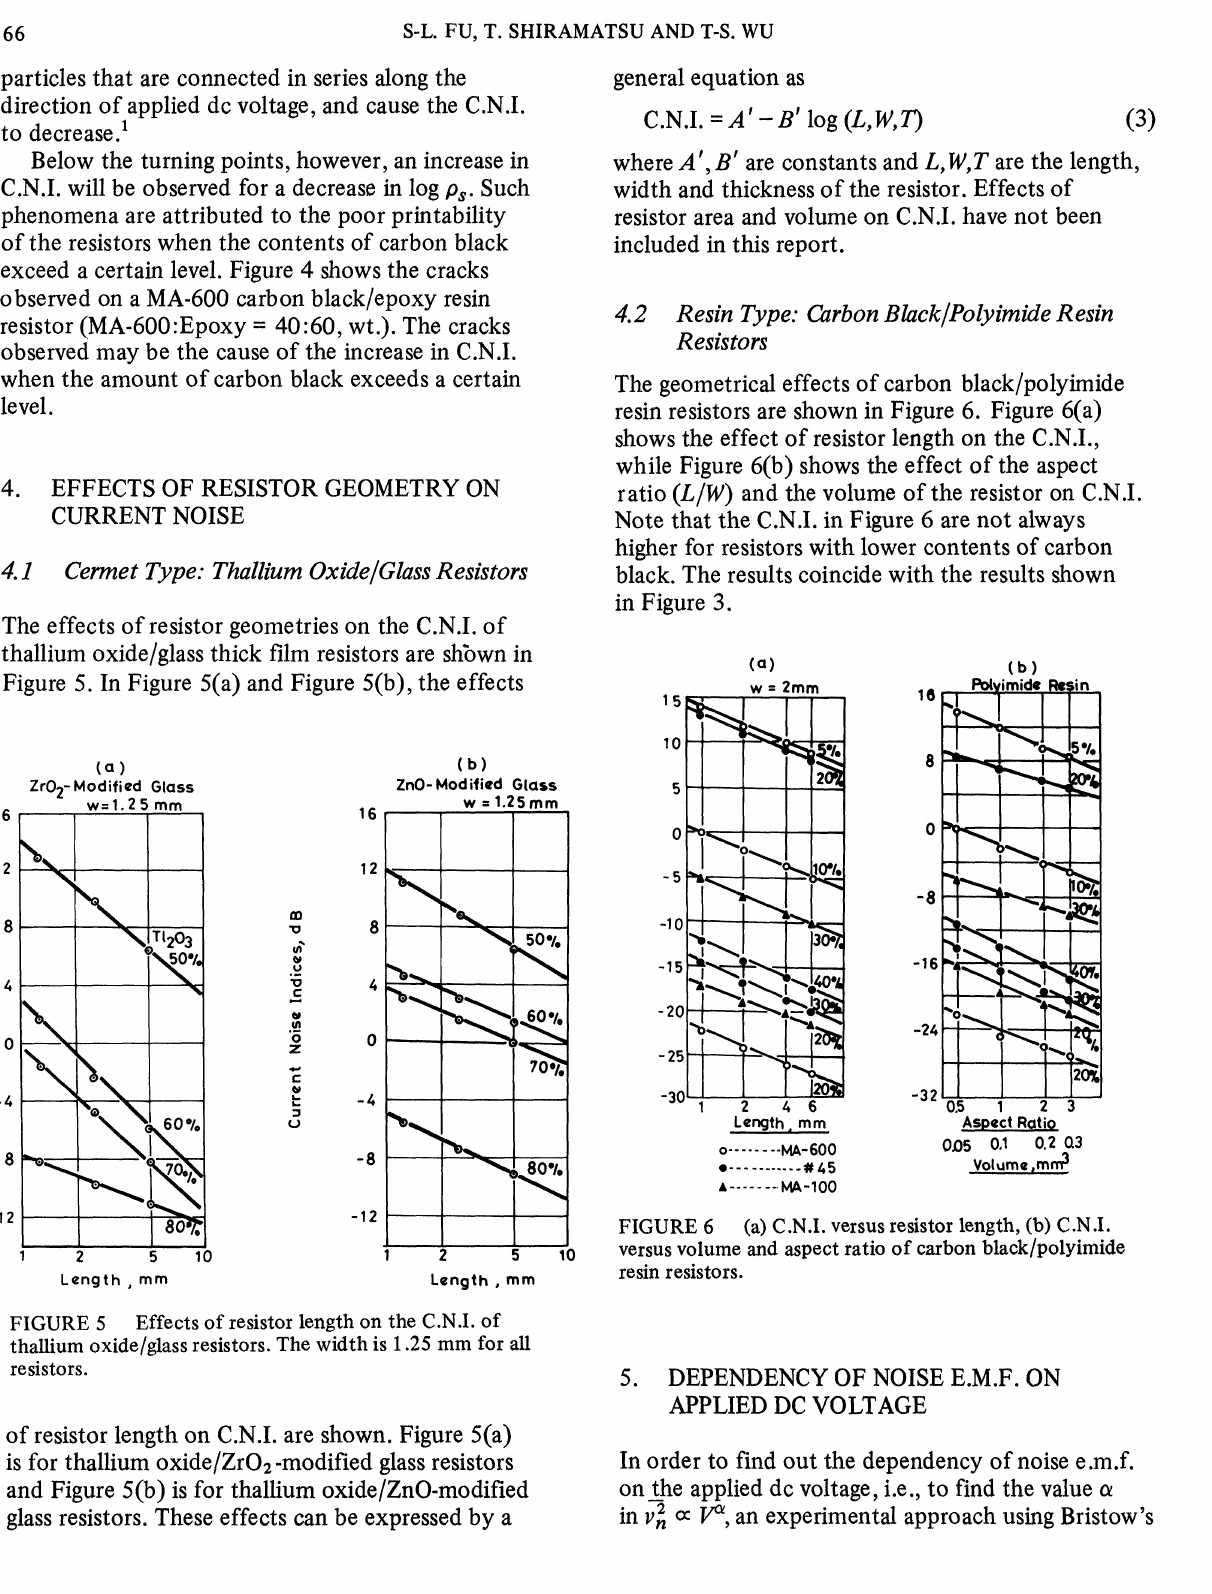
Effects of resistor length on the C.N.I. of thallium oxide/glass resistors. The width is 1.25 mm for all resistors. of resistor length on C.N.I. are shown. Figure 5(a)